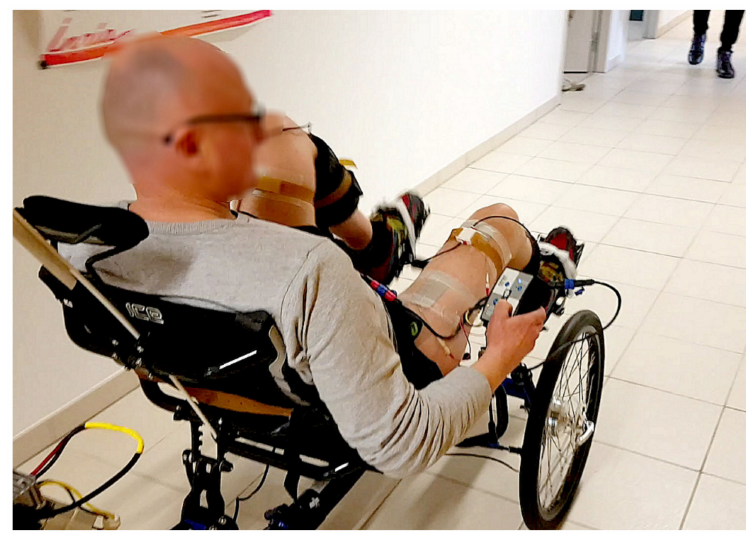
Figure 4. Overground cycling. The participant was able to propel the recumbent trike over a 40-meter corridor.